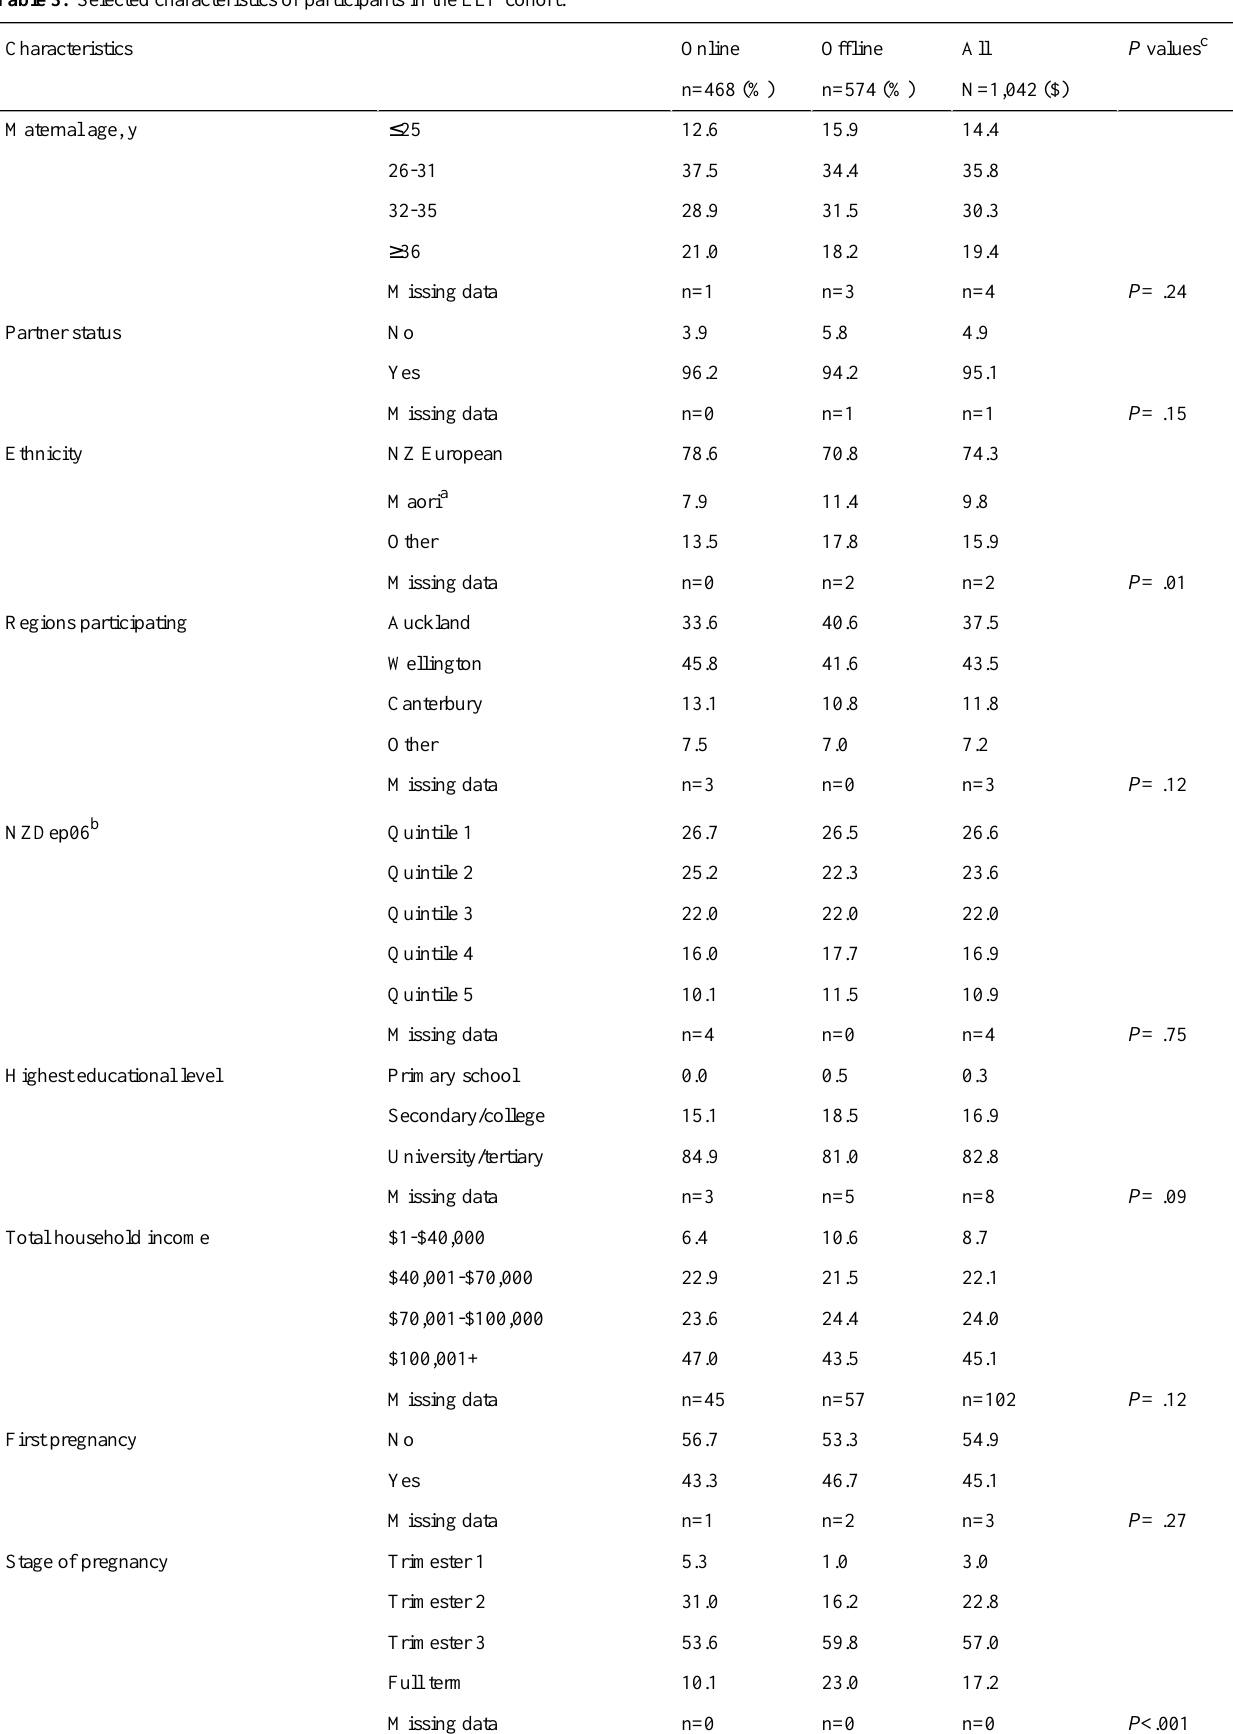
Table 3. Selected characteristics of participants in the ELF cohort.